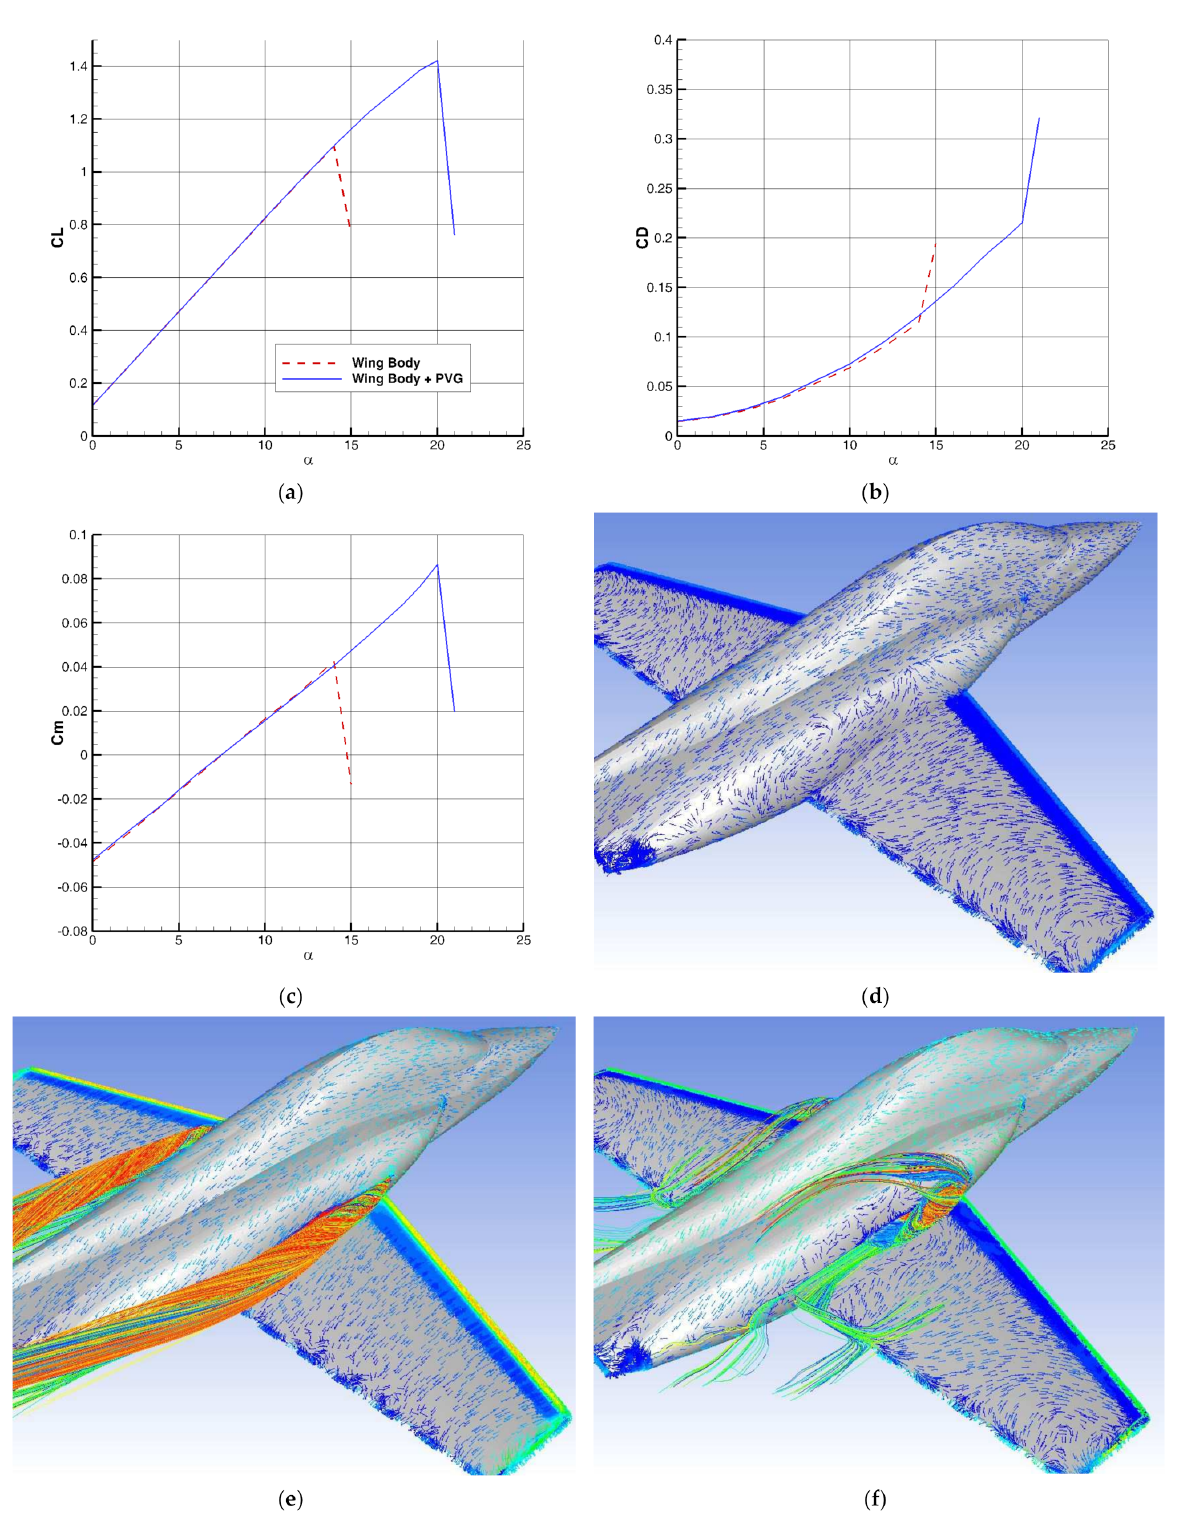
Figure 9. Effect of PVG on the clean configuration in V = 60 m/s: ( a ) C L − α diagram; ( b ) C D − α diagram; ( c ) C m − α diagram; ( d ) the vectors at α = 19 ◦ in the absence of PVG; ( e ) the path lines of PVG and wing-body vectors at α = 19 ◦ ; ( f ) the PVG vortex breakdown in stall point at α = 21 ◦